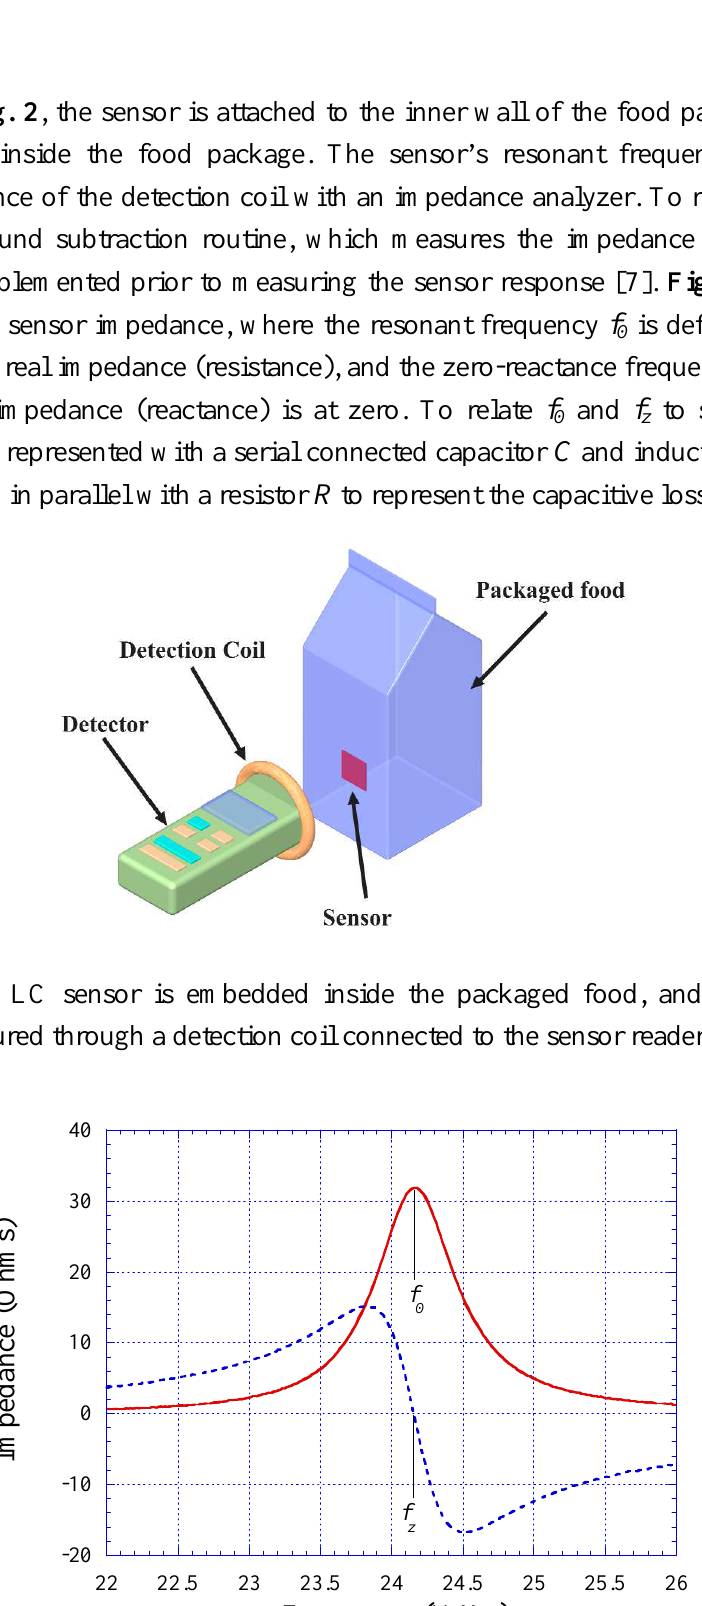
is defined as the maximal of the real 0 is the zero of the imaginary z